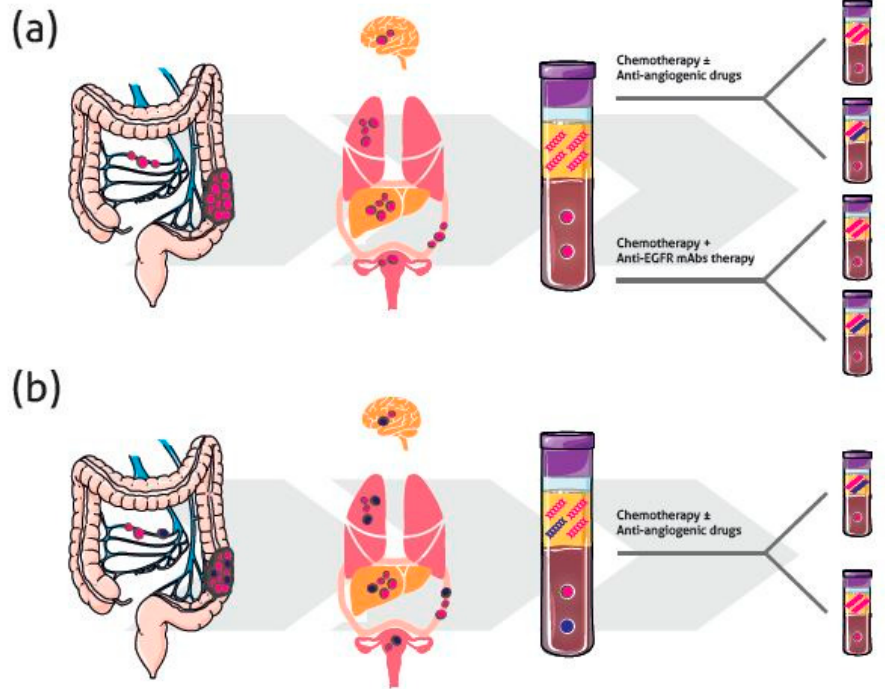
Figure 2. Spatio-temporal heterogeneity and the role of liquid biopsy in the management of mCRC. Example based on RAS mutational status analysis. ( a ) RAS wild type (wt) tumors. Even in an apparently homogeneous genetic context, the selective pressure exerted by drugs can induce de novo mutations or the selection of mutations present at subclonal level in the primary tumor. ( b ) RAS mutated tumors. Heterogeneity can be present within the primary tumor, within metastases, and between primary tumor and metastases. Treatment based on chemotherapy + anti-angiogenic drugs can determine a switch to prevalently wt RAS circulating tumor DNA